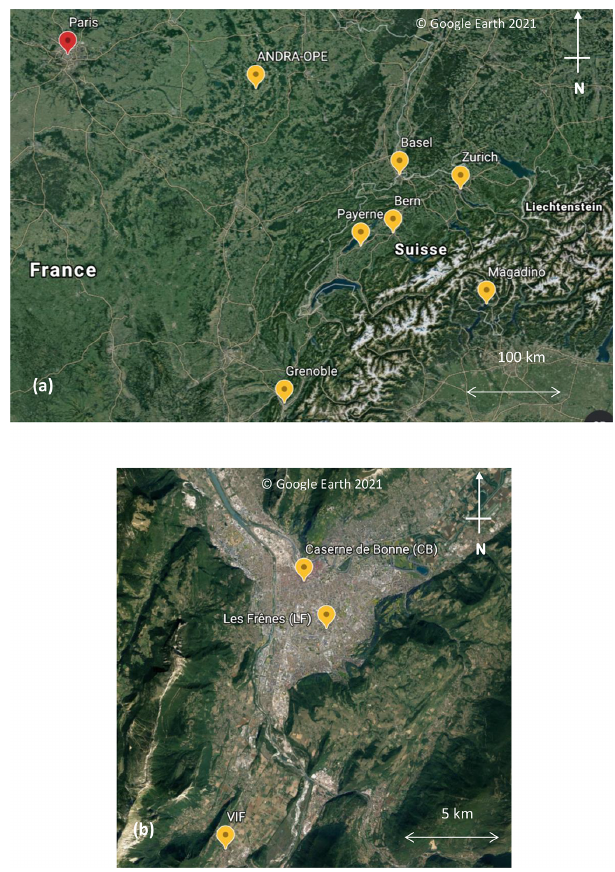
Figure 1. (a) A map of all sampling sites from within the study (highlighted with yellow pin drops). Five sites are sampled within Switzerland; three sites are within the Grenoble metropole; and one is in northern France (ANDRA-OPE). (b) Situation of the three sampling sites within